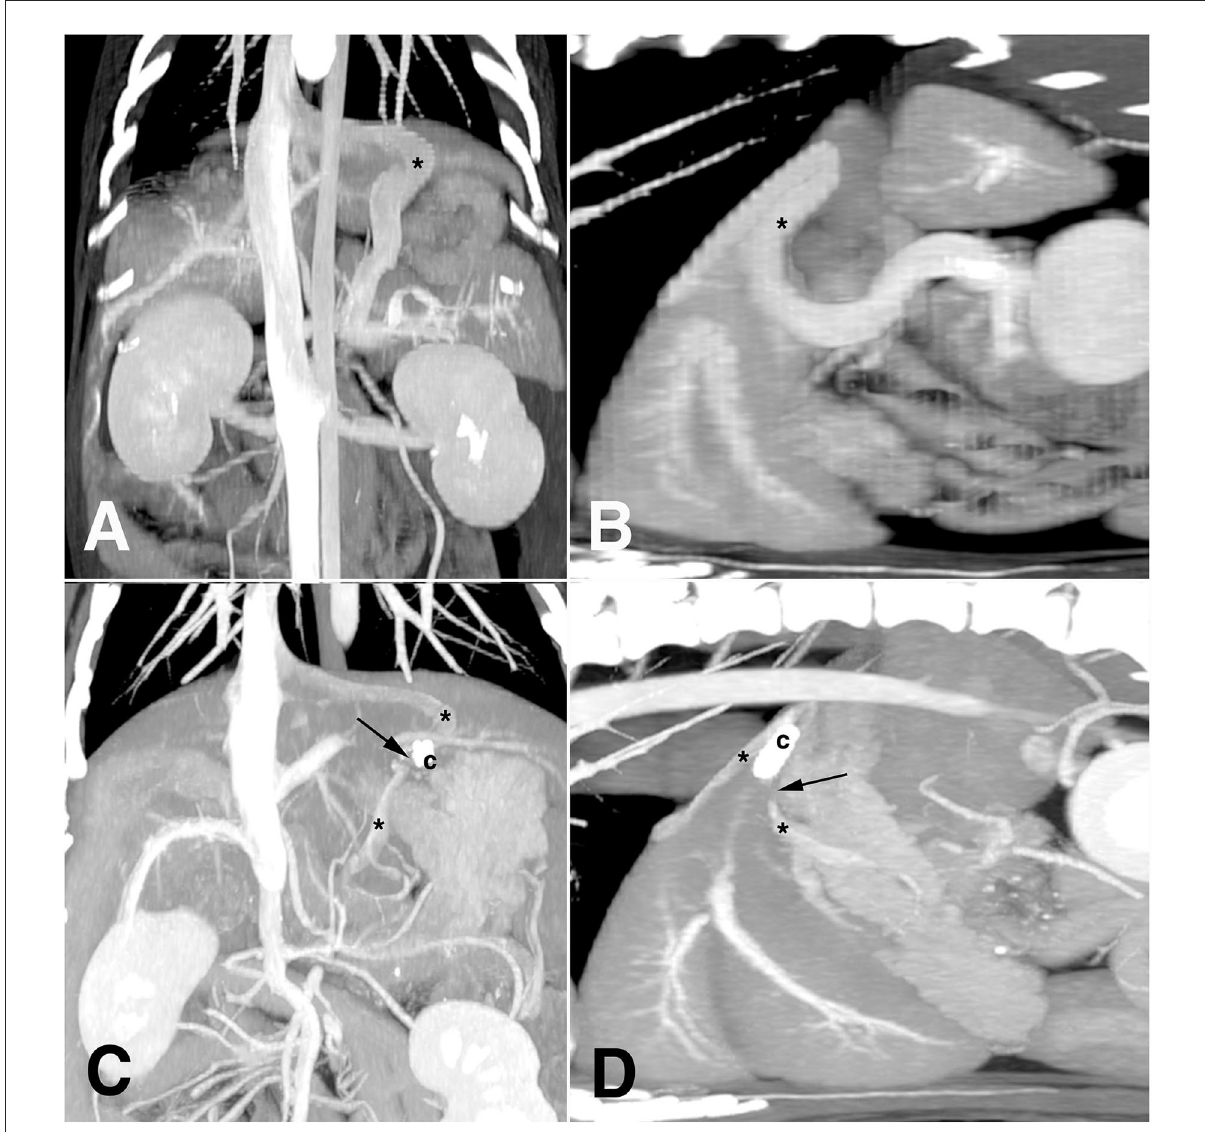
FIGURE1 Diagnostic images of computed tomography angiography before (A,B) and after (C,D) laparoscopic attenuation of canine splenophrenic shunt using thin-film banding. Asterisk, shunting vessel; arrow, vascular gap of complete closure; c, ligation